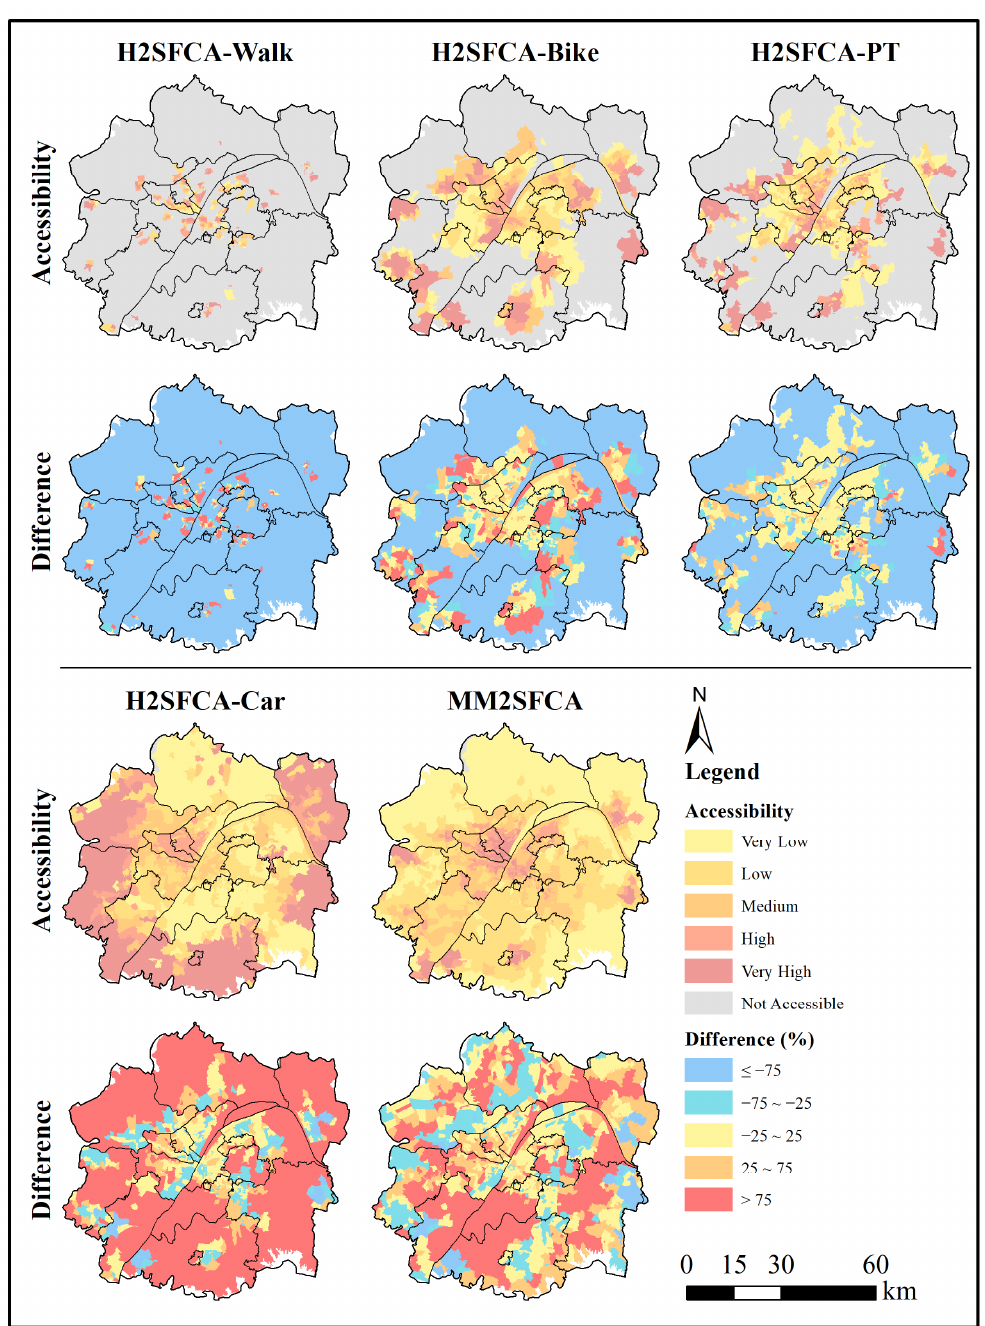
Figure 6. The results of the H2SFCA and MM2SFCA methods and their differences with MMH2SFCA.